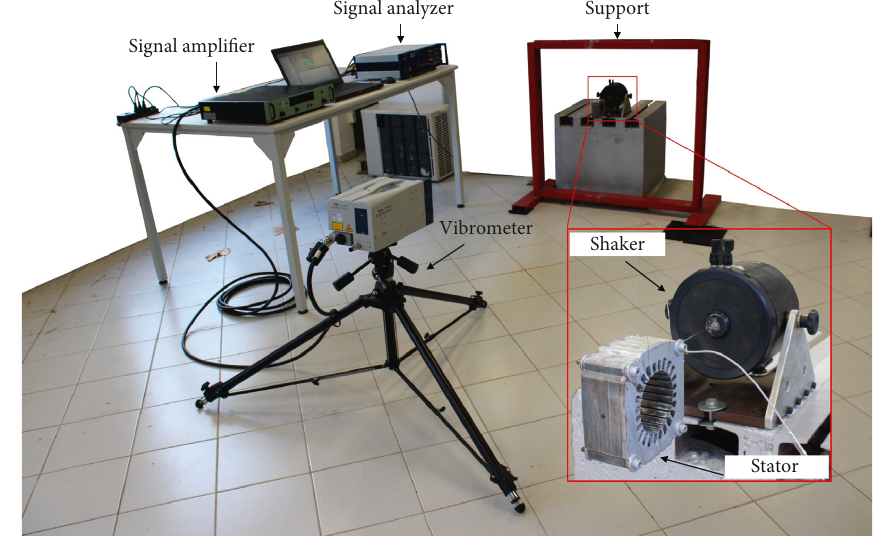
Figure 7: Experimental configuration used in unidirectional modal